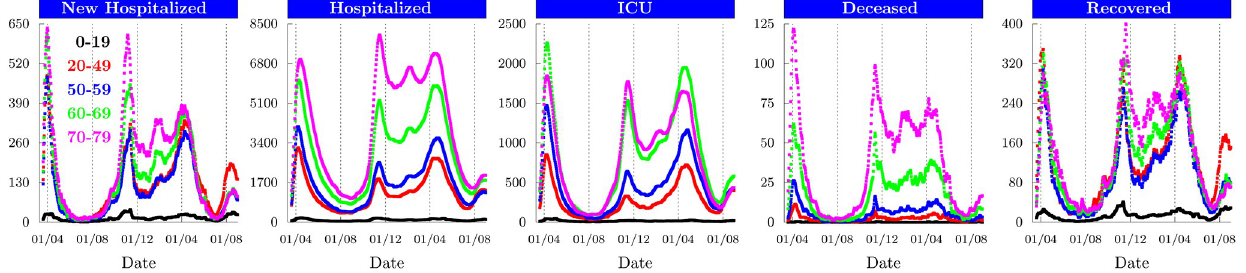
Fig 1. Age-stratified COVID-19 hospitalisation data for France. Daily number of patients newly hospitalised, hospitalised, in Intensive Care Units (ICU), deceased in hospitals and recovered patients that were released from hospitals. Data starting from March 18, 2020. Data sources are [36,